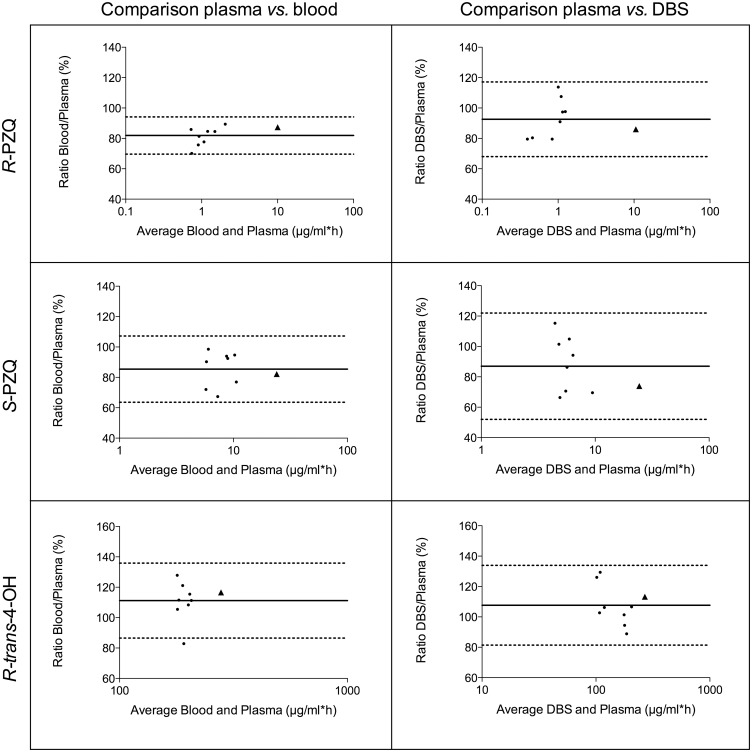
Bland-Altman plots of AUC values obtained from blood or DBS compared to plasma AUCs for R-PZQ, S-PZQ and R-trans-4-OH with mean ratio sketched with a solid line and 95% limits of agreement with dashed lines.Patient 2 is depicted with a triangle (▲).